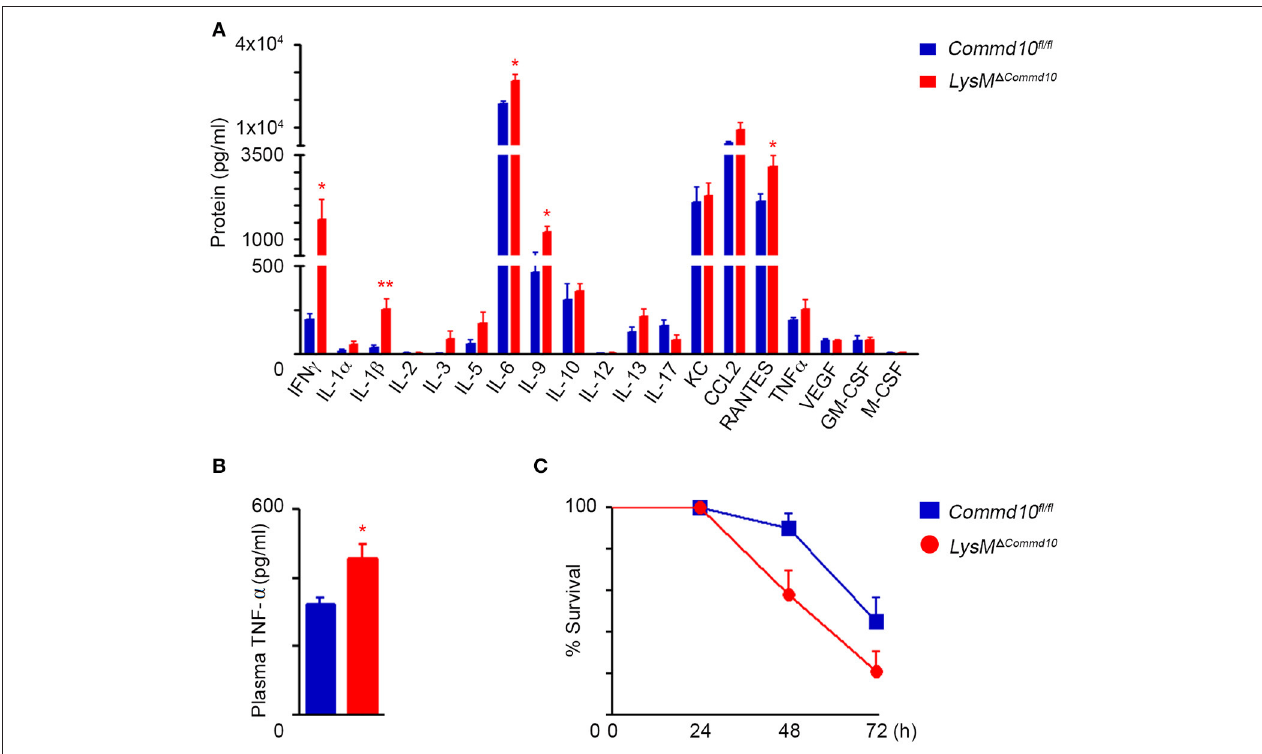
FIGURE 2 | LysM 1 Commd 10 mice exhibit aggravated cytokine storm and mortality in response to systemic LPS challenge. (A,B) Commd10 fl / fl (blue) and LysM 1 Commd 10 (red) mice were i.p. injected with LPS (0.2mg per mouse matched for body mass) and sacrificed 4h later. (A) Multiplex ELISA array of plasma pro-inflammatory cytokines ( n = 4). (B) ELISA analysis of plasma TNF- α ( n ≥ 3). (C) Survival curve over 72h ( n = 10). Data in (A,B) were analyzed by unpaired, two-tailed t- test, comparing each time between Commd10 fl / fl and LysM 1 Commd 10 (red stars), and are presented as mean ± SEM with significance: * p < 0.05, ** p < 0.01. Data in (C) were analyzed by Logrank (Mental-cox method) ( P = 0.03) and Gehan-Breslow-Wilcoxon ( P = 0.02) tests comparing between the Commd10 fl / fl and LysM 1 Commd10 groups. Data in (A,B) represent a single experiment. Data in (C) represent three independent